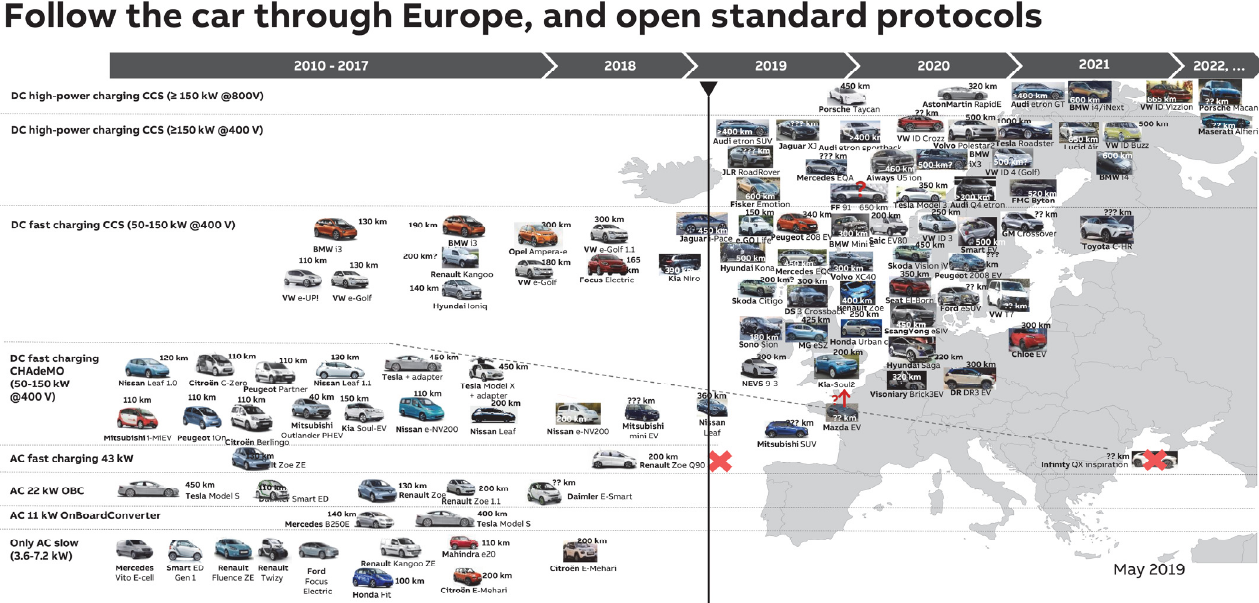
Figure 3. Evolution of EV range and charging capability. (Reprinted with permission from Ref. [29]. Copyright 2019